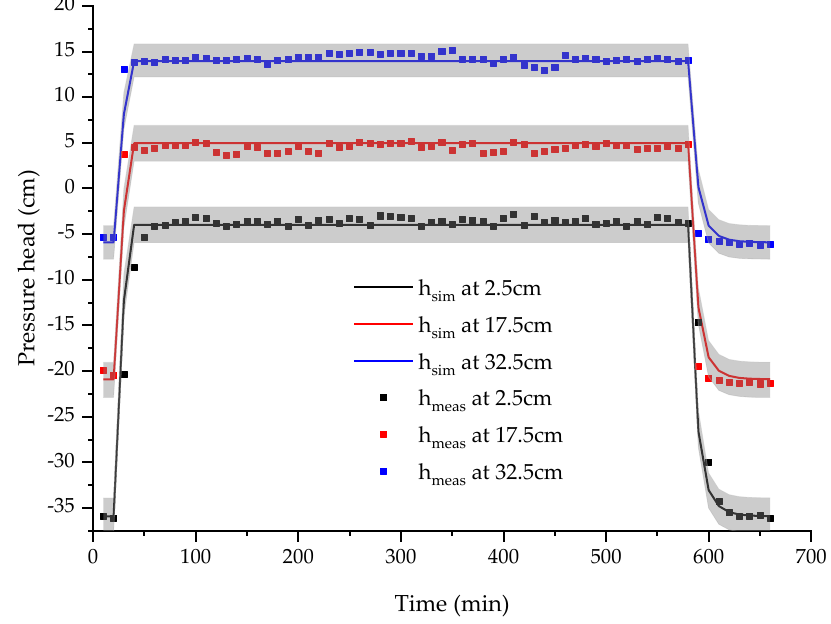
Figure 2. Observed (symbols), calibrated (lines), and predictive uncertainty (grey band) for the pressure head at Z 1 = 2.5 cm, Z 2 = 17.5 cm, and Z 3 = 32.5 cm from the soil surface.